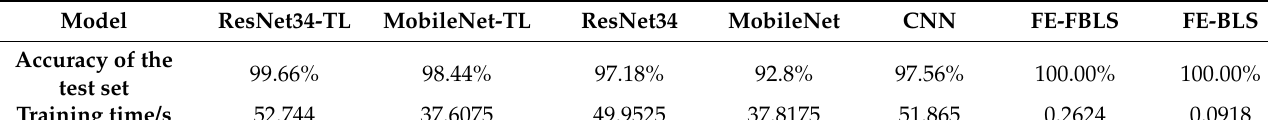
Table 3. Comparison of the accuracy of each classification model.